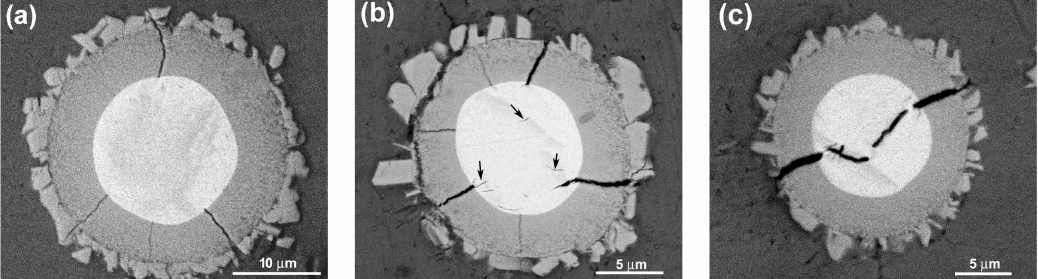
Figure 14. SEM micrographs of crack-having core-shell-structured reinforcing particles in the composites thixoformed at reheating temperatures of ( a ) 600 ◦ C, ( b ) and ( c ) 590 ◦ C after in situ tensile